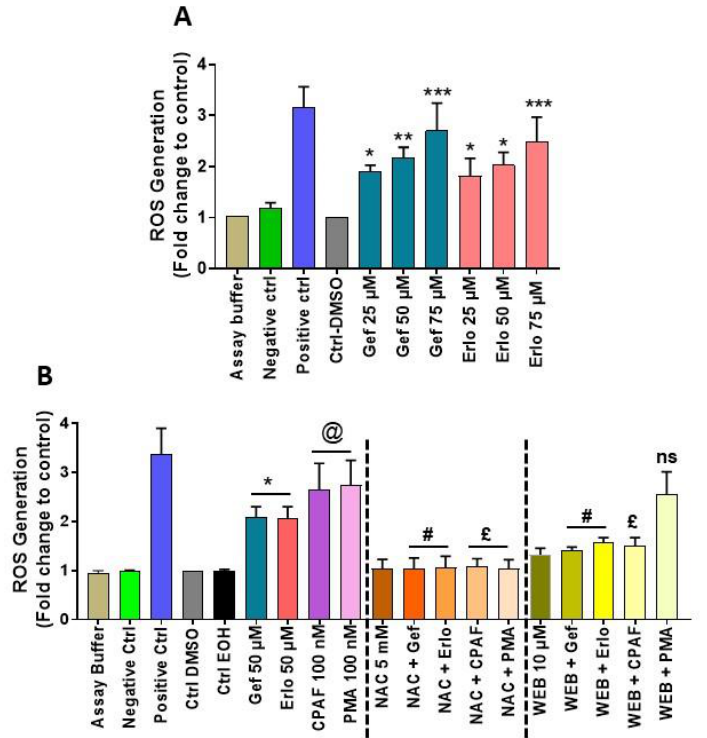
Figure 1. E ff ects of gefitinib and erlotinib on reactive oxygen species (ROS) generation. ( A ) A549 cells were treated with 0.1% dimethyl sulfoxide (DMSO) as vehicle control, and gefitinib (Gef) or erlotinib (Erlo) at 25, 50, and 75 µ M concentrations. The cells were also treated with assay bu ff er, negative and positive controls from the manufacturer’s kit. After 30 min of incubation, ROS generation was measured using a Synergy microplate reader. Data are expressed as mean ± SE of three independent experiments and presented as ROS generation (Fold change to control) versus treatment groups. Statistically significant di ff erences were observed between Ctrl-DMSO and Gef or Erlo at various doses (* = p < 0.05, ** = p < 0.01, *** = p < 0.001). ( B ) A549 cells were pretreated with N-acetylcysteine (NAC; 5 mM) or WEB2086 (10 µ M) for 1 h followed by the treatments with or without Gef, Erlo, carbamoyl-PAF (CPAF), or phorbol myristate acetate (PMA), and after 30 min of incubation, ROS generation was measured. Data are expressed as mean ± SE of five independent experiments and presented similar to Figure 1A. Statistically significant di ff erences were observed between Ctrl-DMSO and Gef or Erlo (* p < 0.05); Ctrl-ethanol (EOH) vs. CPAF or PMA (@ = p < 0.05); Gef vs. NAC + Gef or Erlo vs. NAC + Erlo (# = p < 0.01); Gef vs. WEB + Gef or Erlo vs. WEB + Erlo (£ = p < 0.05); CPAF vs. NAC + CPAF or PMA vs. NAC + PMA (# = p < 0.05); and CPAF vs. WEB + CPAF (£ = p < 0.05). ns denotes non-significant change between PMA and WEB +